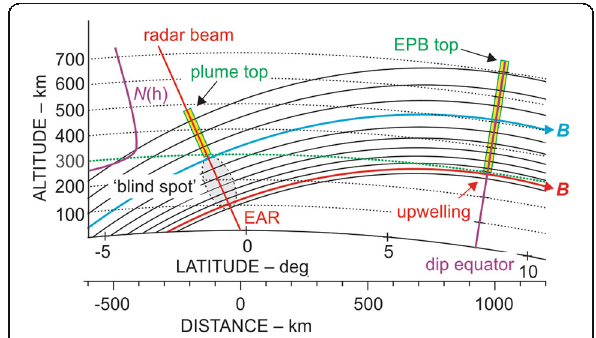
Fig. 13 Sketch of the geometric relationship (in the magnetic meridian) that determines where a plume (green-lined bar with yellow fill) would be detectable with the EAR. The ‘ blind spot ’ is a region, below the base of the local N profile, where N is too low to support radar backscatter, regardless of whether an EPB is present on those B lines over the dip equator (which is also shown with a green-lined bar with yellow fill). In other words, plumes can be detected only at altitudes above the blue B